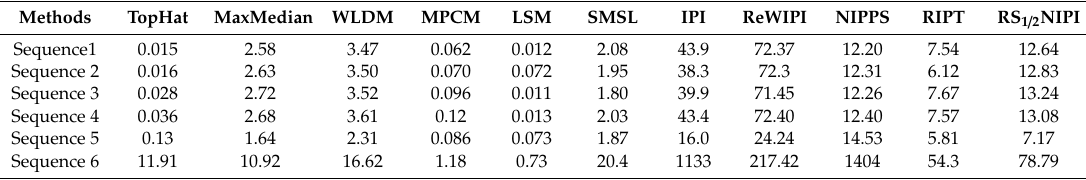
Table 6. The average running time ( / s) of each frame in sequences